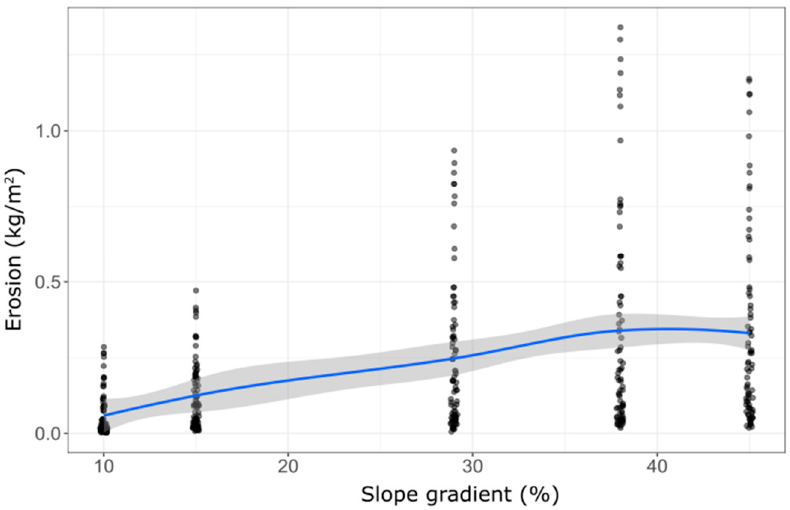
Figure 8. Slope gradient and erosion rate ( _____ LOESS fit line with 95% confidence intervals).